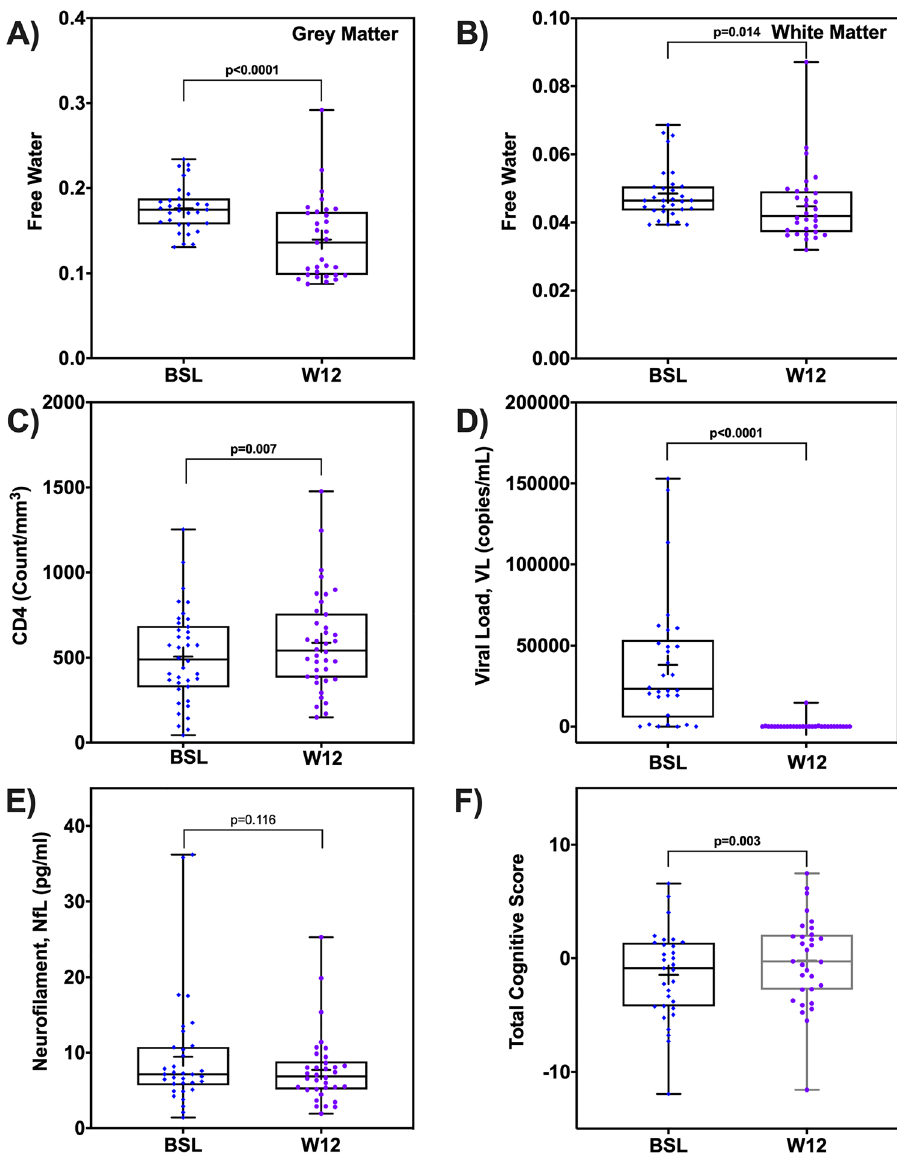
Figure 2. Short term effect of cART treatment on free water, blood markers, and cognitive scores. The box-and- whisker plots illustrate the comparison of free water (FW) index in ( A ) grey matter (GM) and ( B ) white matter (WM); ( C ) CD4 + T cell counts, ( D ) Viral Load (VL), ( D ) average neurofilament light chain (NfL), and E) Total cognitive score in the HIV+ participants. Note: p-values are shown; + sign indicates mean of each measure at each time point. BSL, baseline; W12,